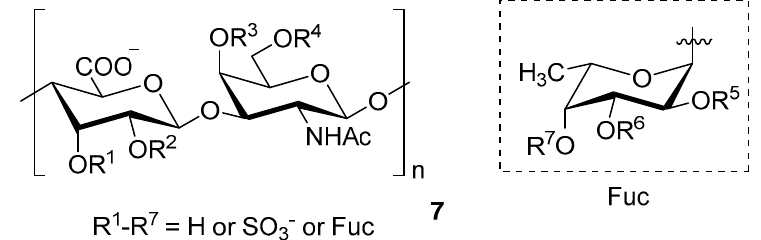
Figure 5. General chemical structure of fucosylated chondroitin sulfate ( 7 ).